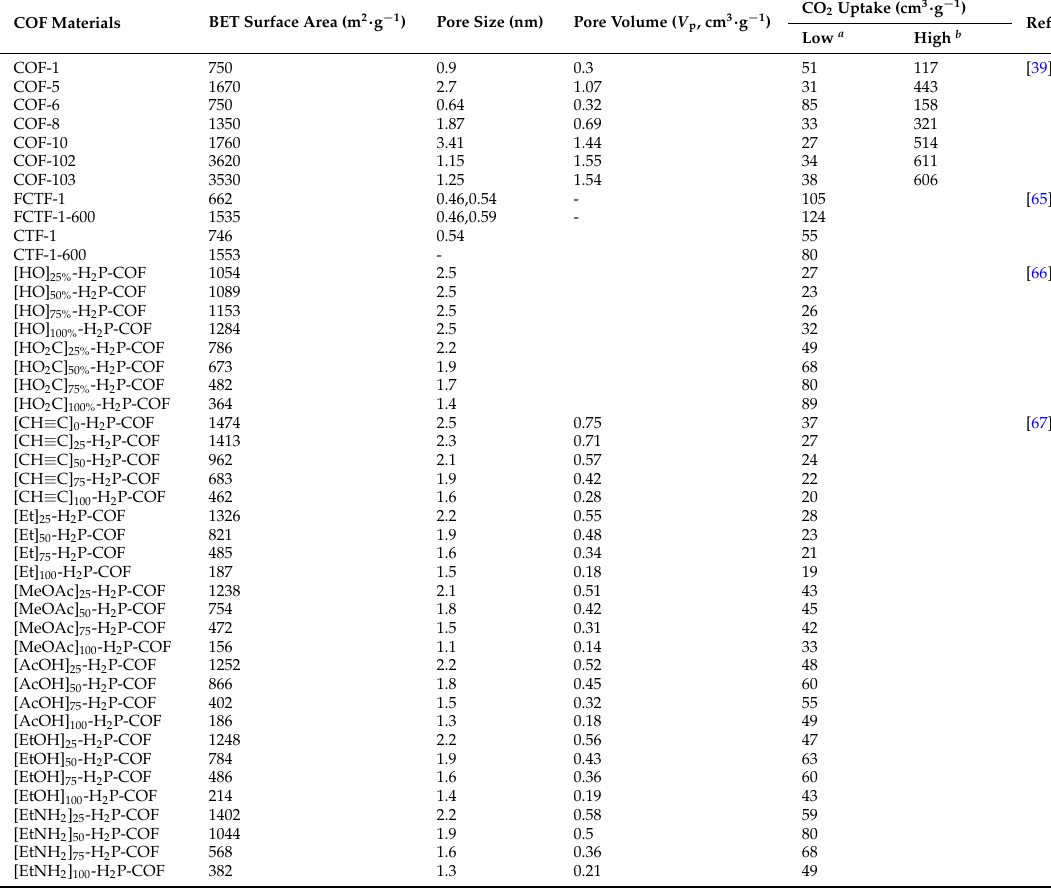
Table 3. BET surface area, porosity parameters and CO 2 capture of selected